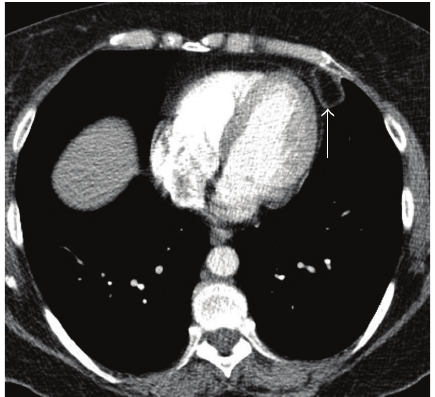
Figure 1: CT scan without contrast enhancement showing a left anterior low-attenuation ( − 80HU) pericardial mass with high attenuation strands surrounded by an irregular capsule (arrow) and a small pleural effusion (arrowhead).